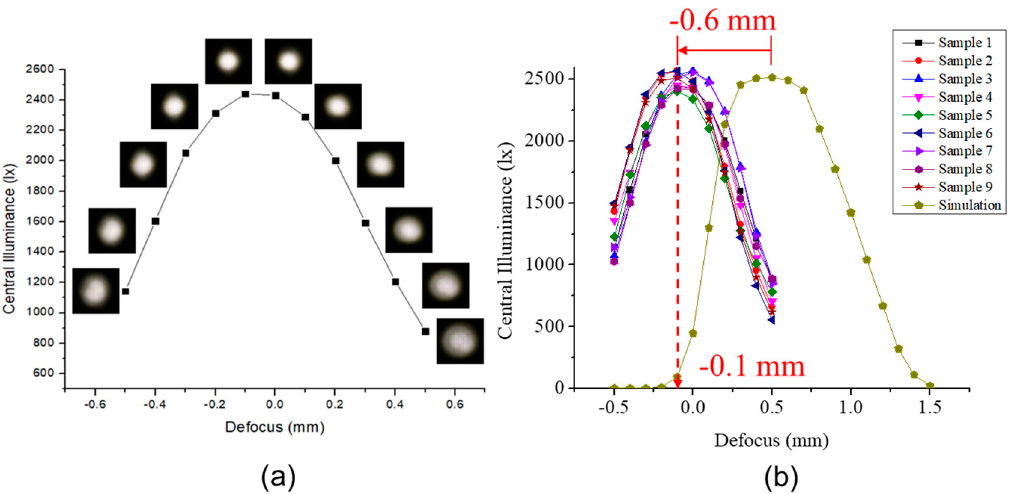
Figure 8. ( a ) Projection spots and variation of the central illuminance when the pcW-LED was shifted longitudinally. ( b ) Plot of the measured central illuminance versus the defocus for nine samples. The dark green line represents the results for the original design. The measurement was conducted for an injection current of 1.5 A with a heavy heat sink.